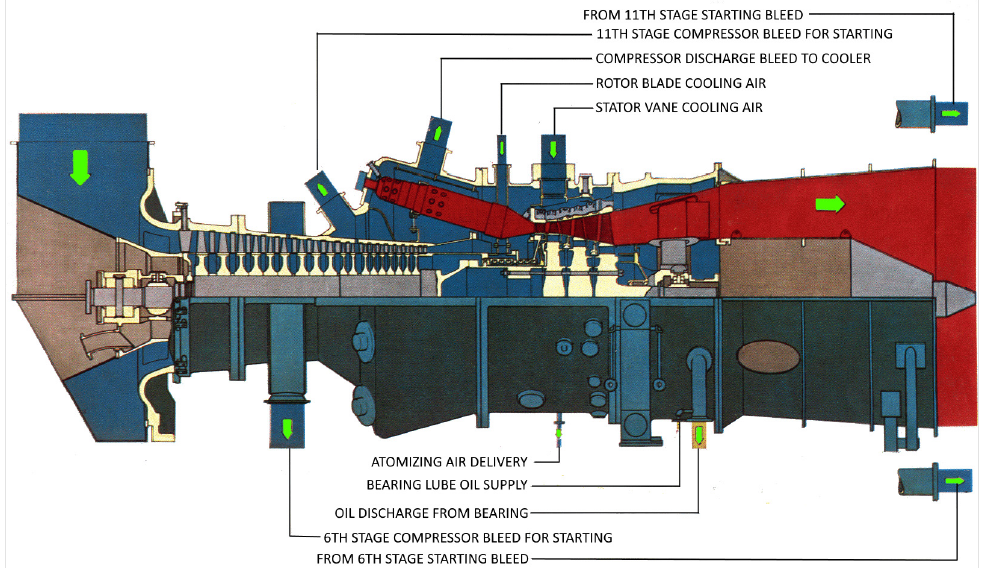
Figure 1. Turbine section along the axis. Green arrows indicate the gas primary and secondary-flow direction.